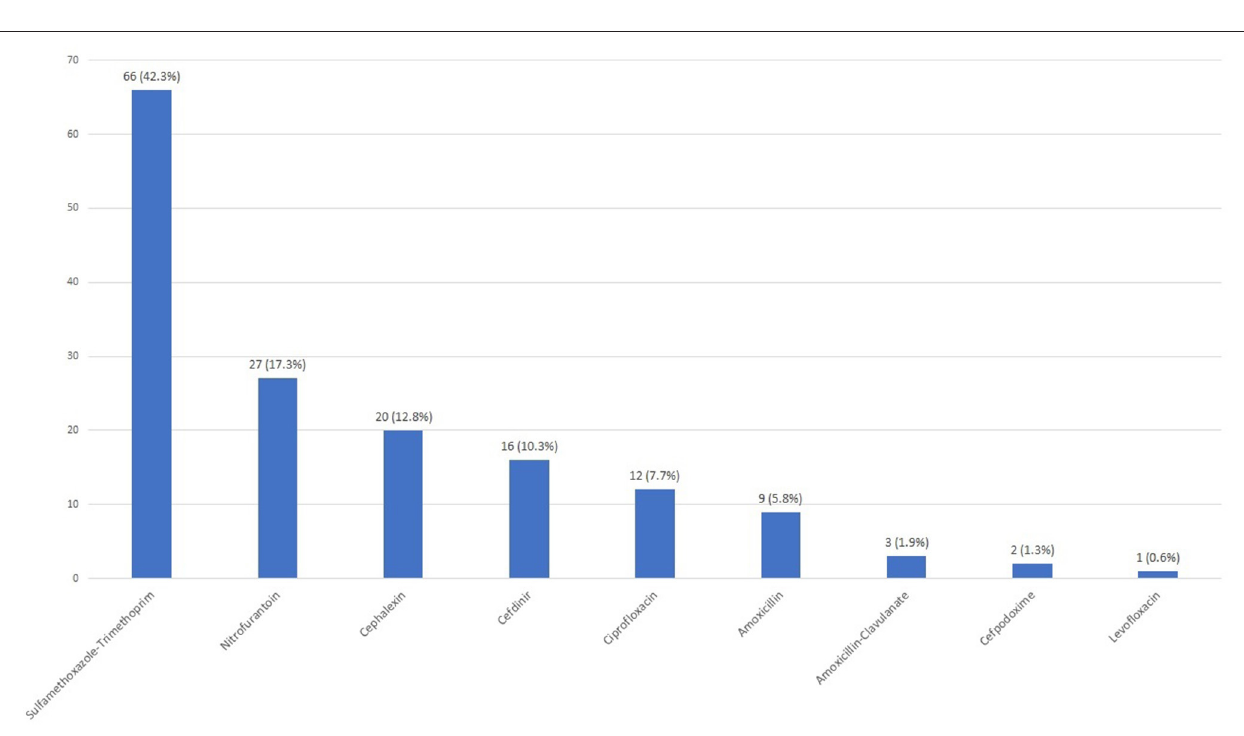
Table 1 reflect the community population with respect to race and